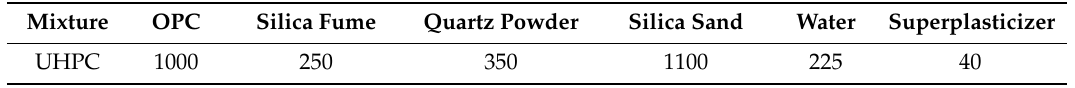
Table 1. Mix proportions of specimens by weight